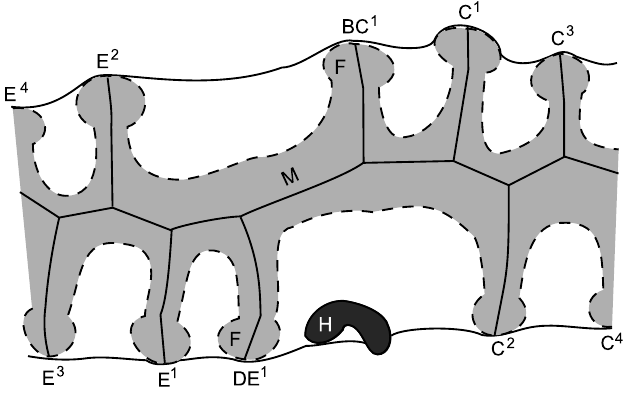
Fig. 18. Ambulacra and brachioles in the callocystitid Pseudocrinites pyri­ formis Paul, 1967a, Ludlow (Silurian), England, UK. The mouth and food grooves are hidden by cover plates (shaded). Both ambulacra start with two brachiole facets on the left. These are interpreted as BC 1 and C 1 in the C ambulacrum and DE 1 and E 1 in the E ambulacrum (left). F, facet; H, hydropore; M, mouth. Redrawn from Paul 1967a: 329, fig.